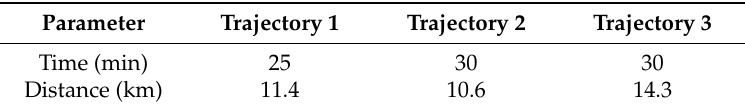
Table 1. Trajectory